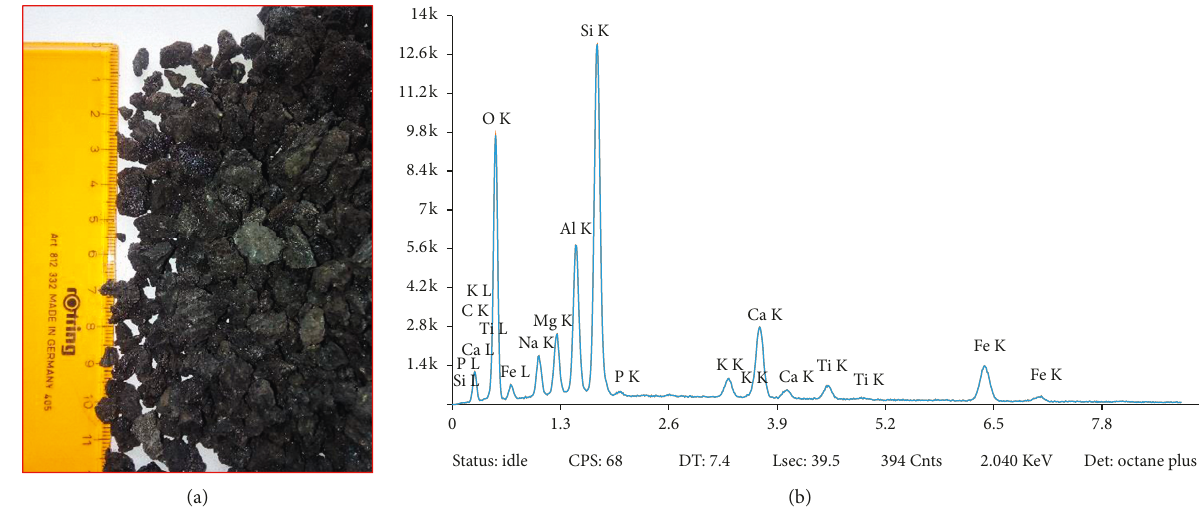
Figure 1: Macrograph of (a) the investigated volcanic scoria and (b) the EDX analysis.